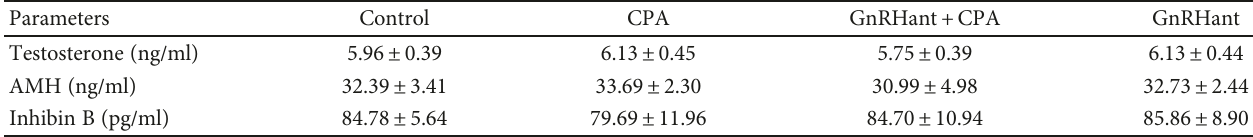
Table 2: Serum levels of testicular